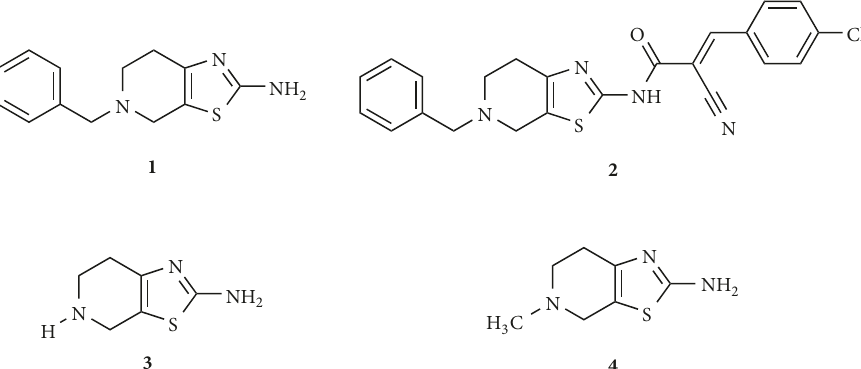
Figure 2: Chemical structure of tetrahydrothiazolo[5,4-c]pyridine-2-amine (TR-01) and its derivatives (TR-02–4) used in this study.